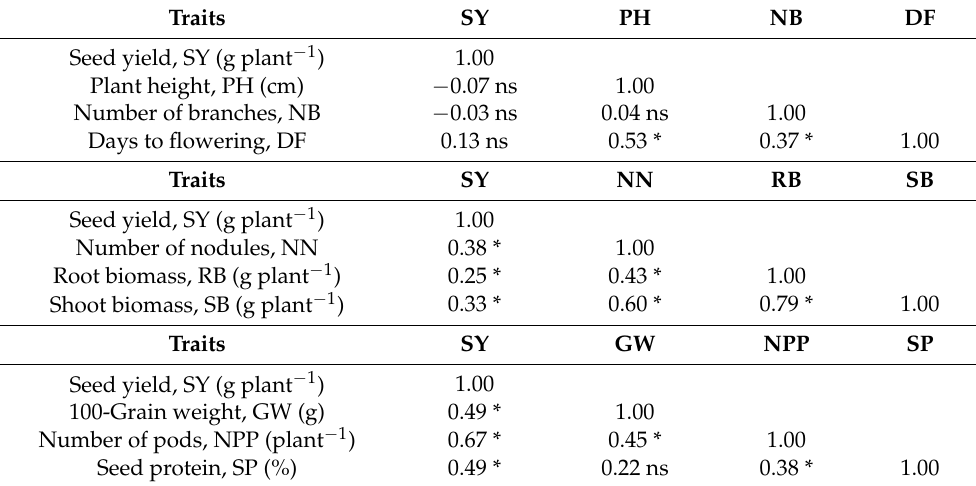
Table 11. Correlation coefficients analysis among seed yield (SY), plant height (PH), number of branches (NB), days to flowering (DF), number of nodules (NN), root biomass (RB), shoot biomass (SB), 100-grain weight (GW), total number of pods per plant (NPP), and seed protein (SP) of different soybean genotypes at different P fertilizer sources.